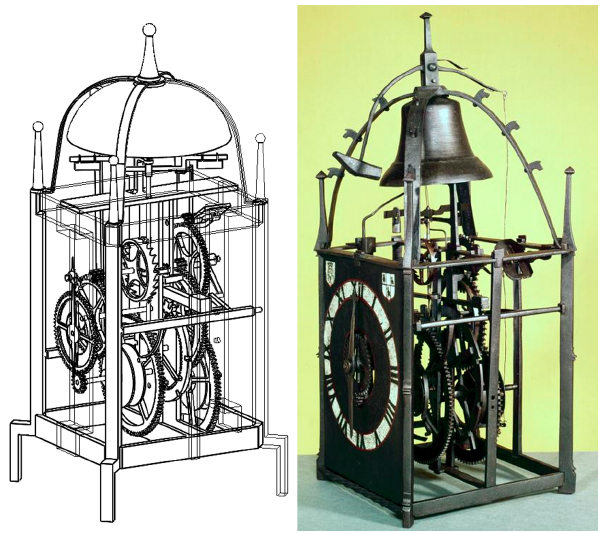
Figure 19. N7 – German iron chamber clock (Science Museum,